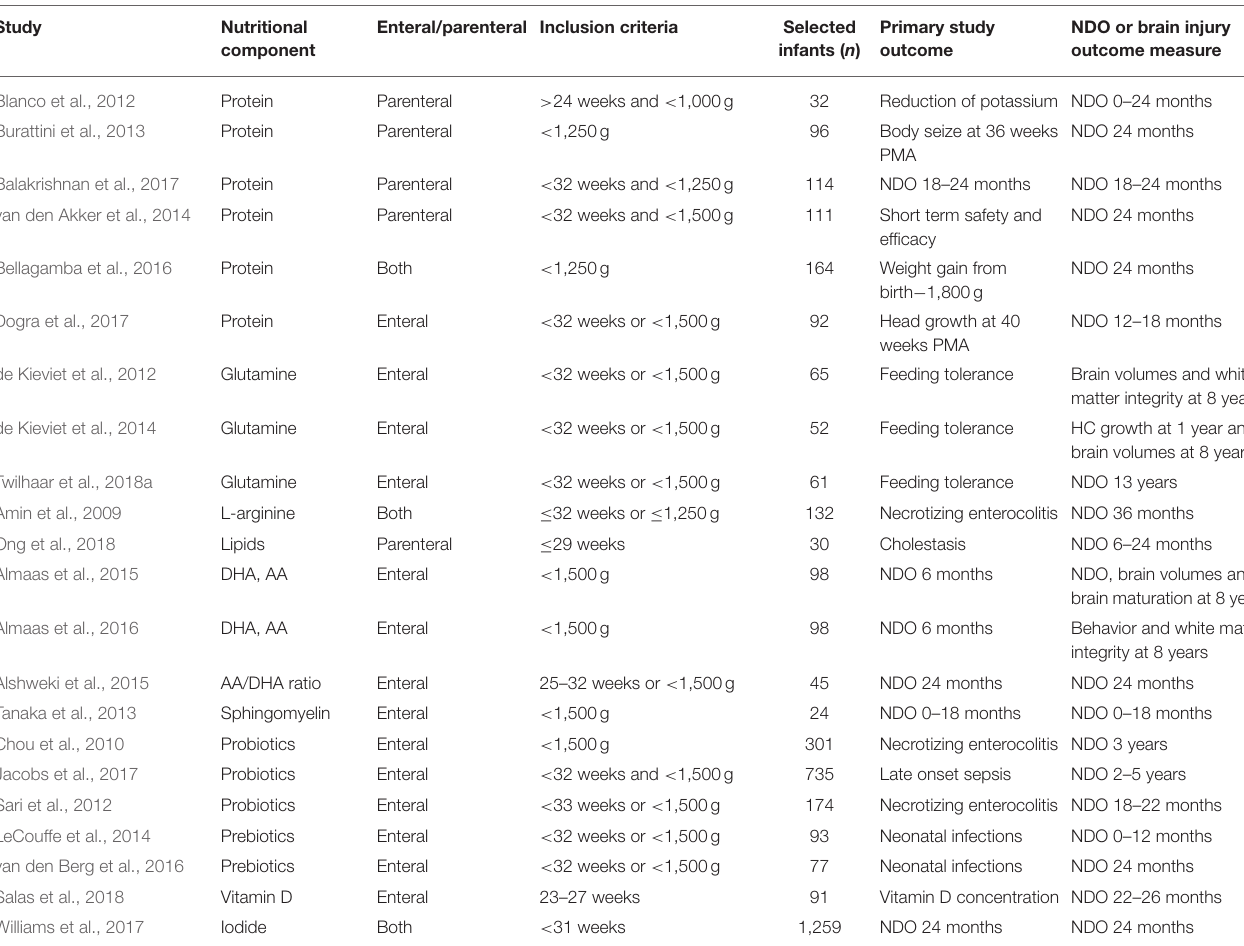
TABLE 2 | Baseline characteristics of included clinical